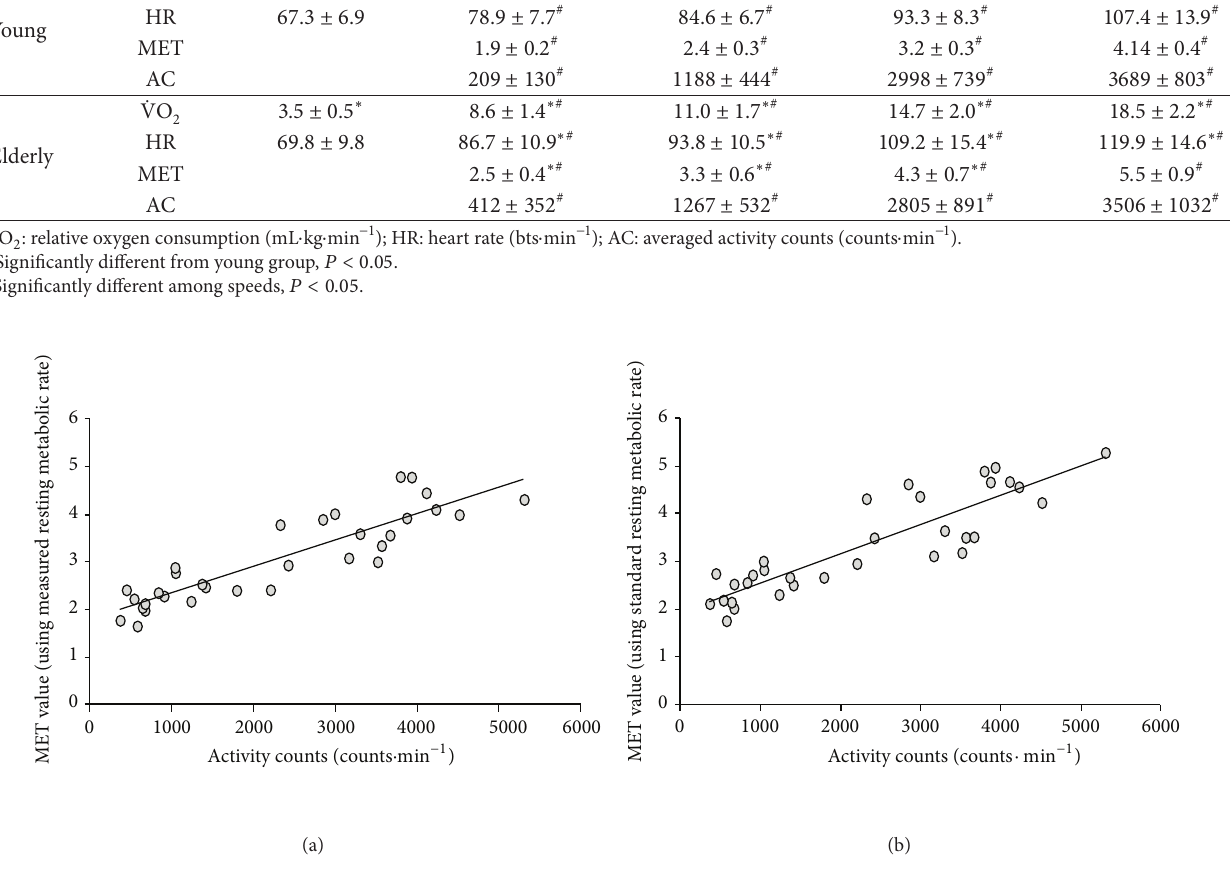
Figure 2: (a) Relationship between MET values and activity counts for young group using measured metabolic rate ( 𝑅 2 = 0.80 , standard error of estimate = 0.40 ). (b) Relationship between MET values and activity counts for young group using standard (3.5 mL ⋅ kg ⋅ min −1 ) metabolic rate ( 𝑅 2 = 0.82 , standard error of estimate = 0.41